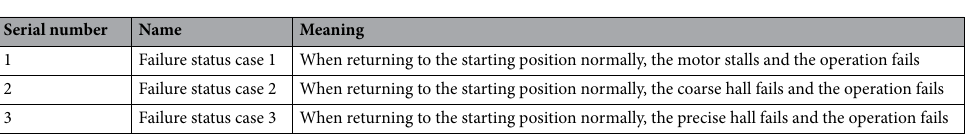
Figure 4. Flow chart of wavelength scanning mechanism returning to starting position.